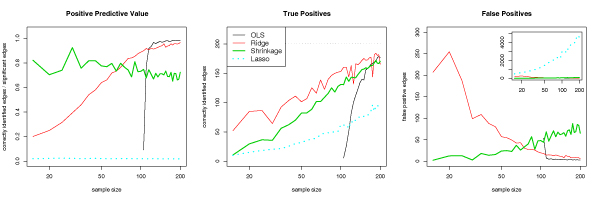
Relative performance of the four investigated methods for learning VAR networks in terms of positive predictive value (true discovery rate) and the number of true and false edges. The thin dotted line in the middle box at 200 corresponds to the true number of edges in the simulated networks.